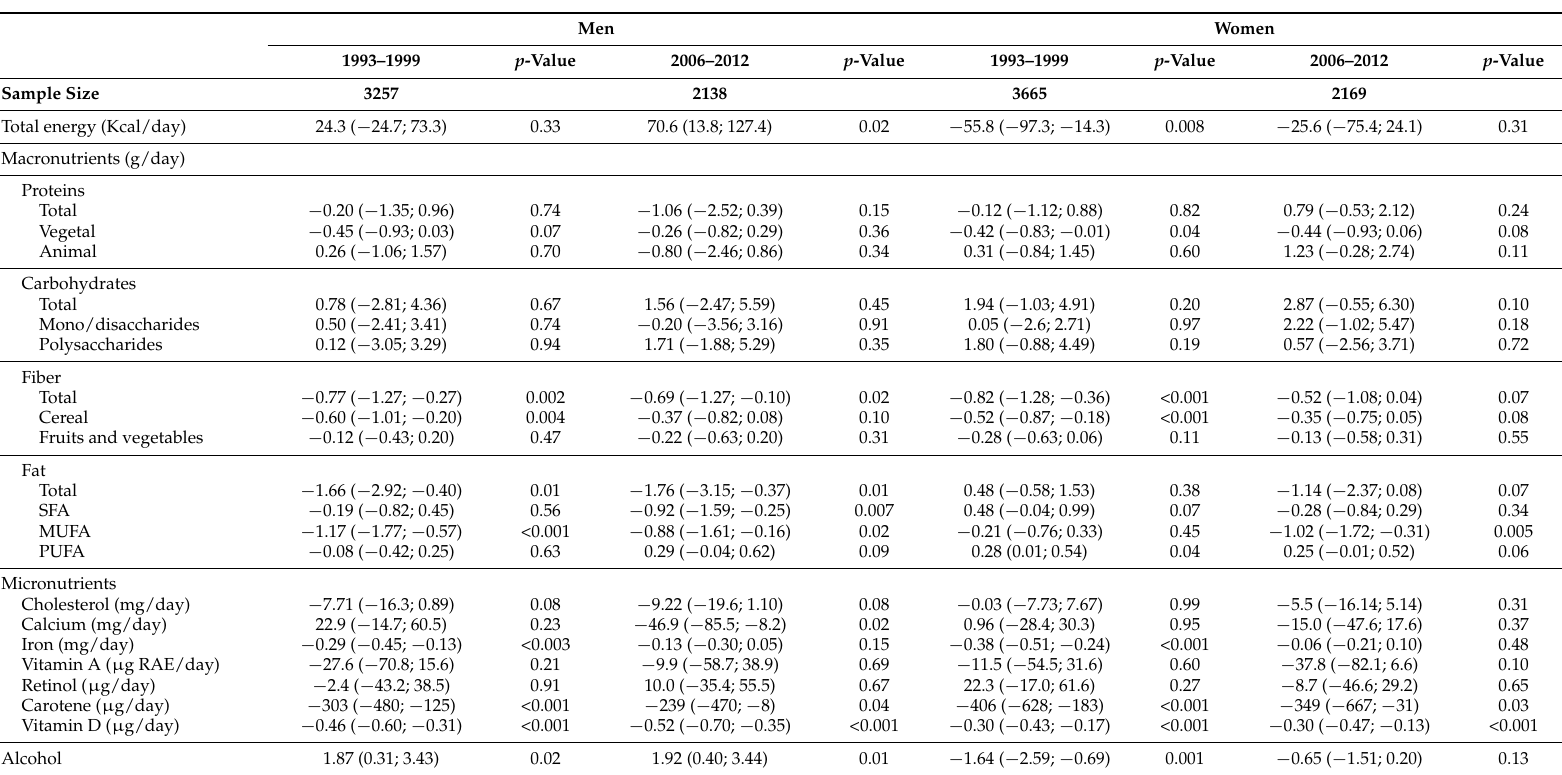
SFA, saturated fatty acids; MUFA, monounsaturated fatty acids; PUFA, poly-unsaturated fatty acids; RAE, retinol activity equivalent. Results are expressed as multivariable adjusted differences (low vs. high) and (95% confidence interval) in nutrient intake between low and high educational categories. Statistical analysis by analysis of variance adjusting for age, country of birth (dichotomized into Switzerland yes/no), marital status, smoking status and total energy intake (for